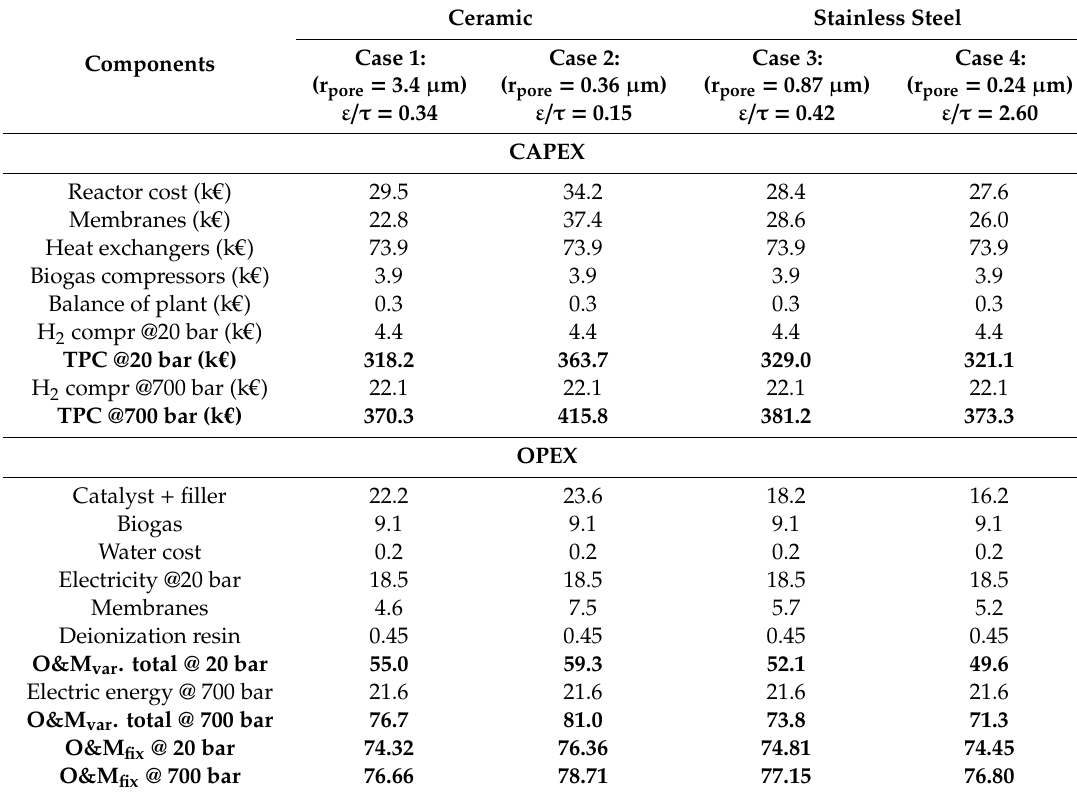
Table 11. CAPEX and OPEX for the di ff erent cases